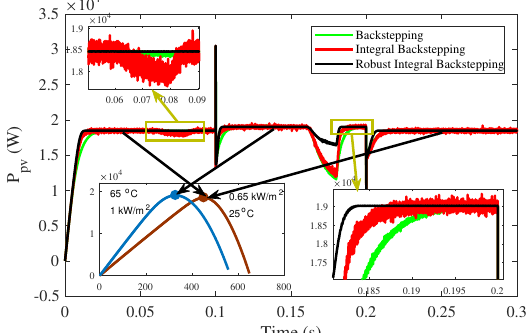
Figure 15. Output power of PV array with multiple faults under varying temperature and irradiance.